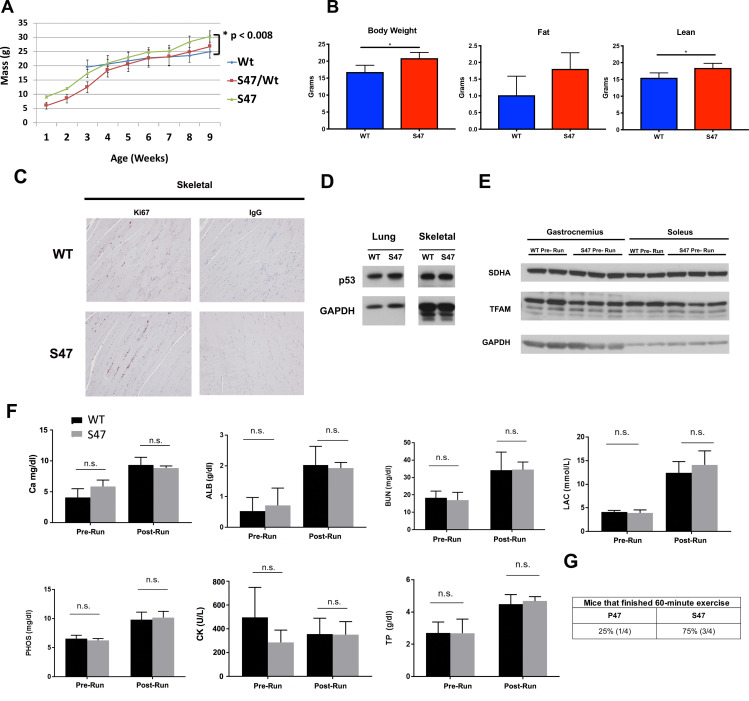
Serum metabolites and protein markers pre- and post- exercise.(A) Record of mouse weights in WT, S47 and heterozygous WT/S47 mice over the course of 18 weeks; a minimum of 10 mice of each genotype were tracked, and error bars mark standard error. (B) Body weight, fat content, and lean content as measured by proton magnetic resonance spectroscopy (H-MRS); n = 5 mice per genotype, error bars mark standard error, (*) p-value<0.05. (C) Ki67 immunohistochemical staining of skeletal muscle from WT and S47 mice. IgG control shown on right. (D) Total p53 protein levels in WT and S47 lung and skeletal tissue. (E) Whole cell lysates were extracted from gastrocnemius or soleus muscle from untreated WT and S47 mice and subjected to western blot analysis for the proteins indicated. (F) Blood serum metabolite levels measured in WT and S47 mice before and after treadmill run: Ca (calcium), ALB (albumin), PHOS (phosphate), CK (creatine kinase), BUN (blood urea nitrogen), LAC (lupus anticoagulant), TP (total protein). n.s. not significant, Student’s t-test. (G) WT and S47 mice were subjected to a 60 min treadmill run. Table indicates proportion of mice that completed run; n = 4.